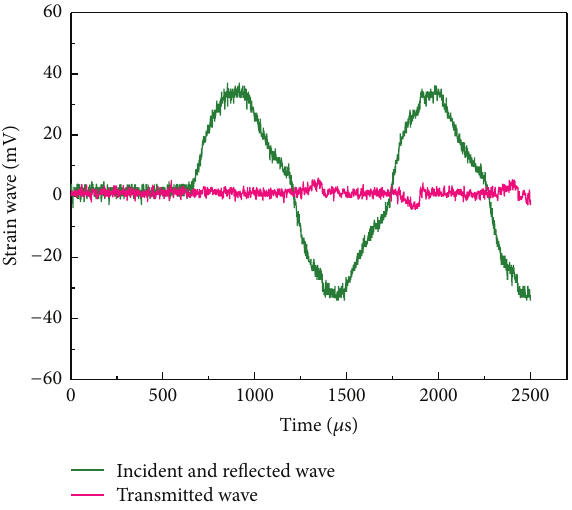
Incident and reflected wave Transmitted Figure 8: Strain waveform for the dynamic fracture test.